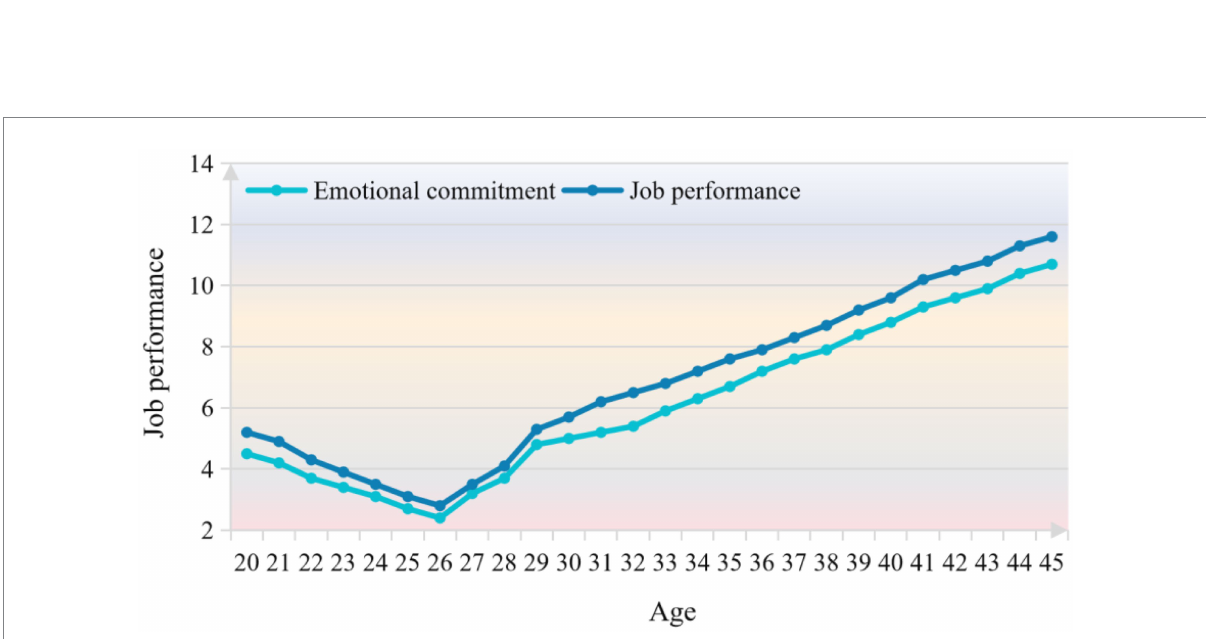
FIGURE 8 Changes of employees’ emotional commitment and job performance level with